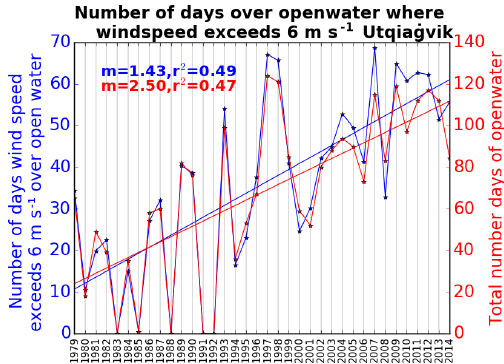
Figure 6. Annual time series from 1979 to 2014 of the number of days deemed too windy for boat travel for subsistence hunting ( > 6ms − 1 ; Ashjian et al., 2010) and number of open water days (number of days less than 15% sea ice concentration). Data are from WRF-downscaled